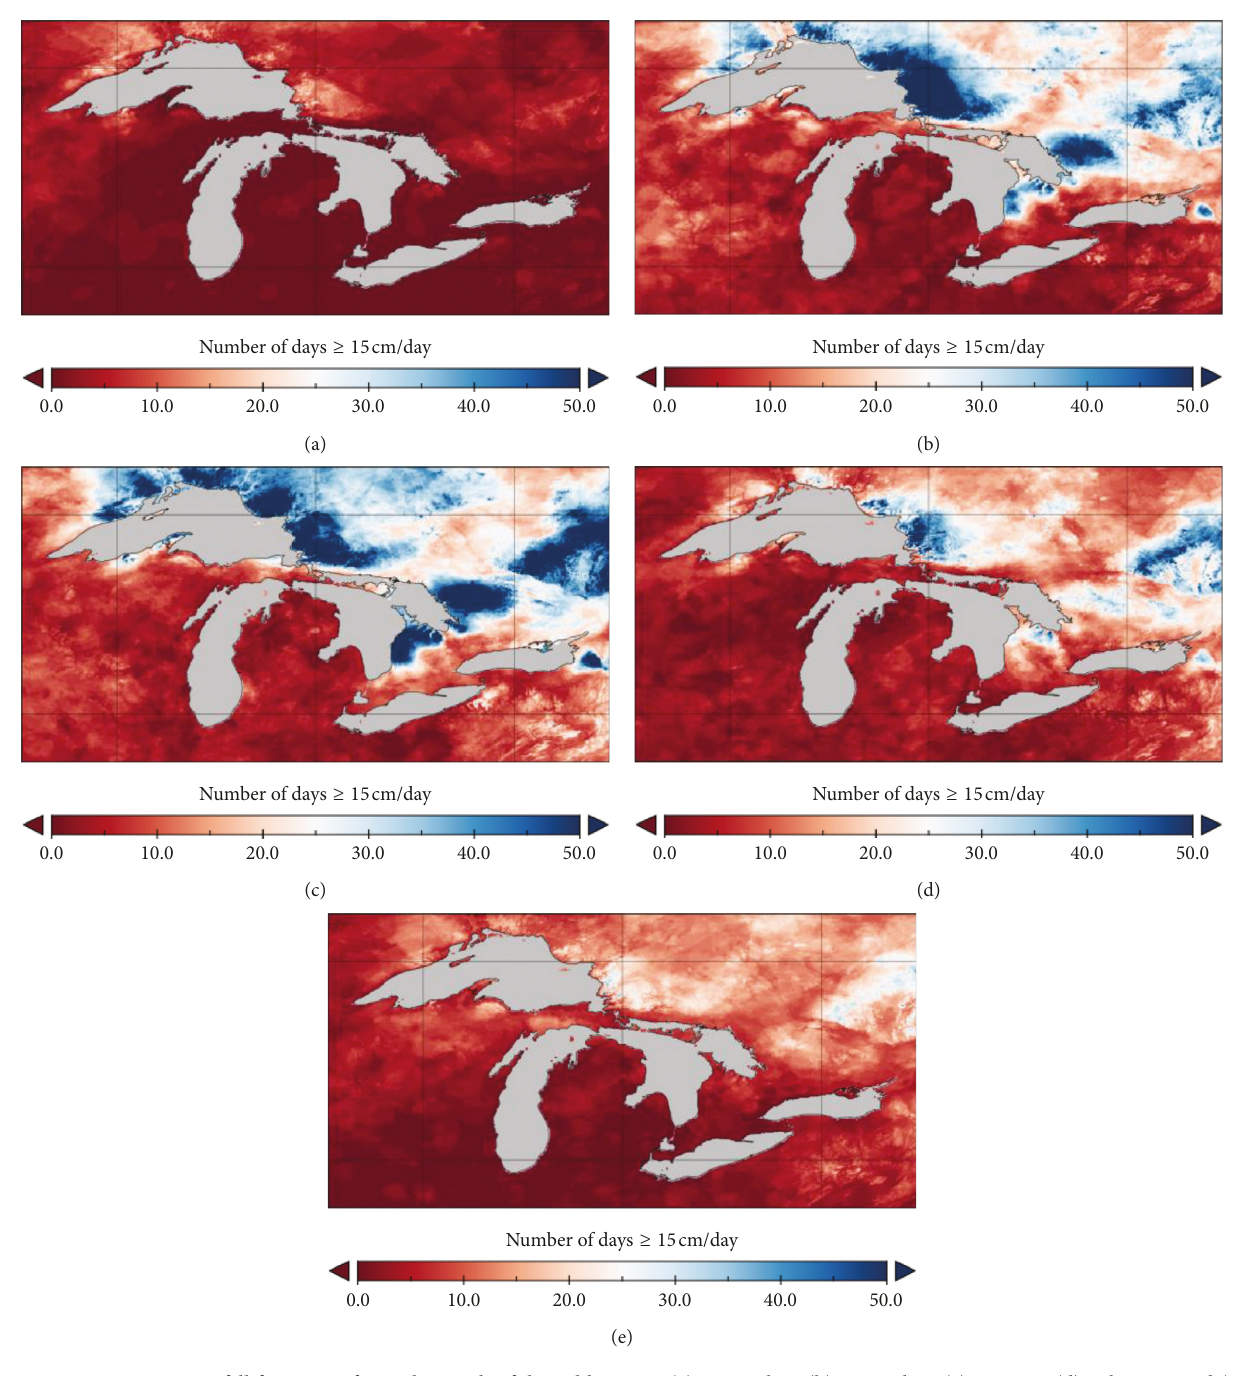
Figure 3: Extreme snowfall frequency for each month of the cold season: (a) November, (b) December, (c) January, (d) February, and (e) March. Extreme snowfall frequency is defined as the number of days when daily snowfall amounts equaled or exceeded S_threshold of 15cm/day between 1980 and